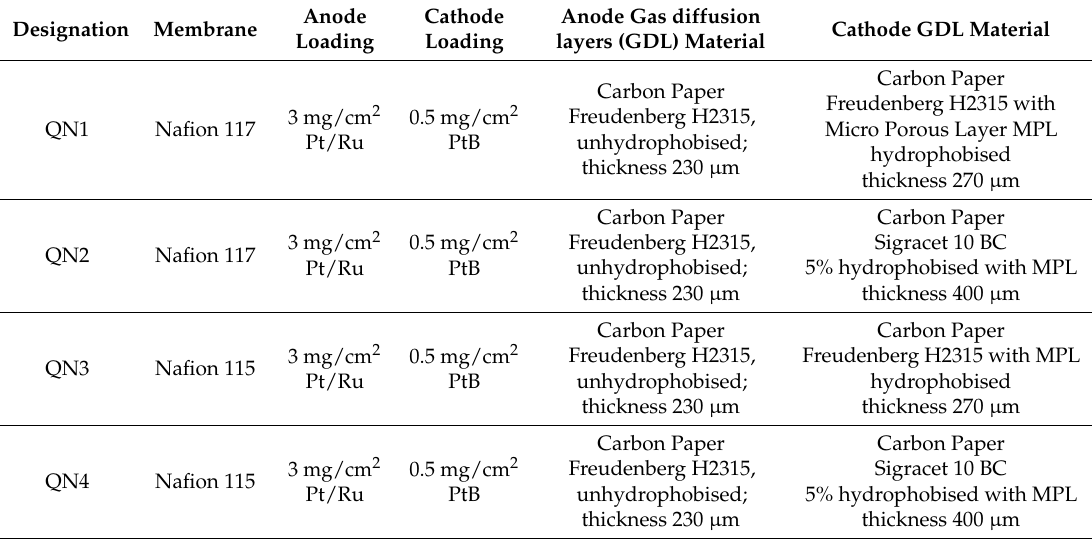
Table 1. Characteristics of the MEA’s used in this